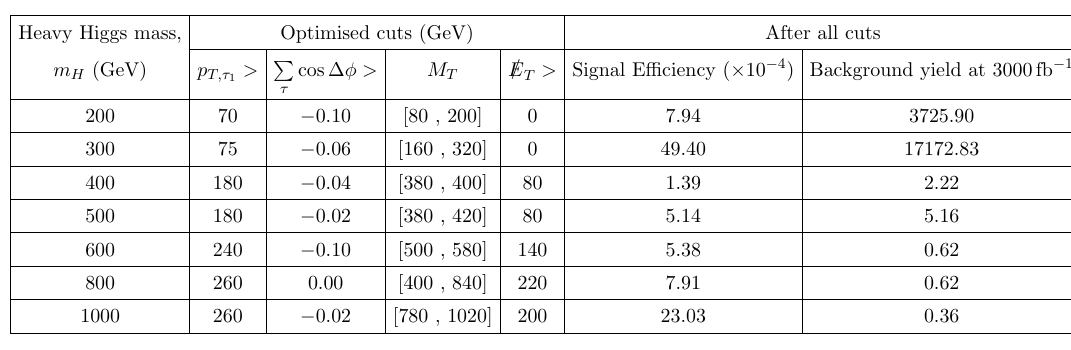
Table 17 . The details of (cid:12)nal optimised cuts with signal e(cid:14)ciency and background yields after all the applied cuts.